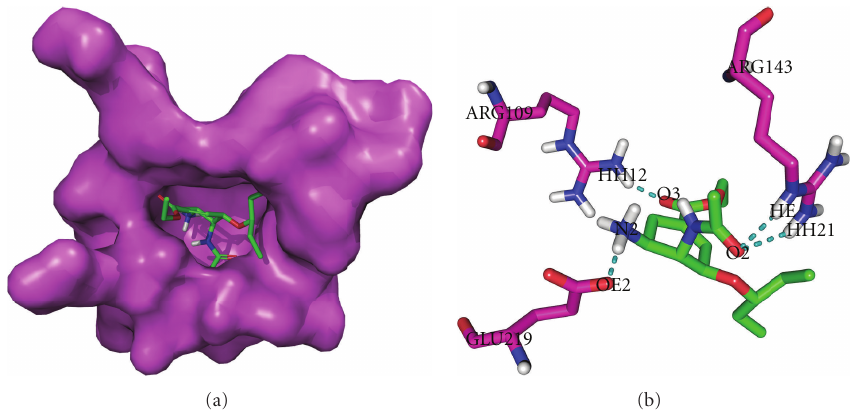
Figure 3: (a) Docking of Oseltamivir on the NA surface reported from Schrodinger, (b) interaction of Oseltamivir on the NA by hydrogen- bond.